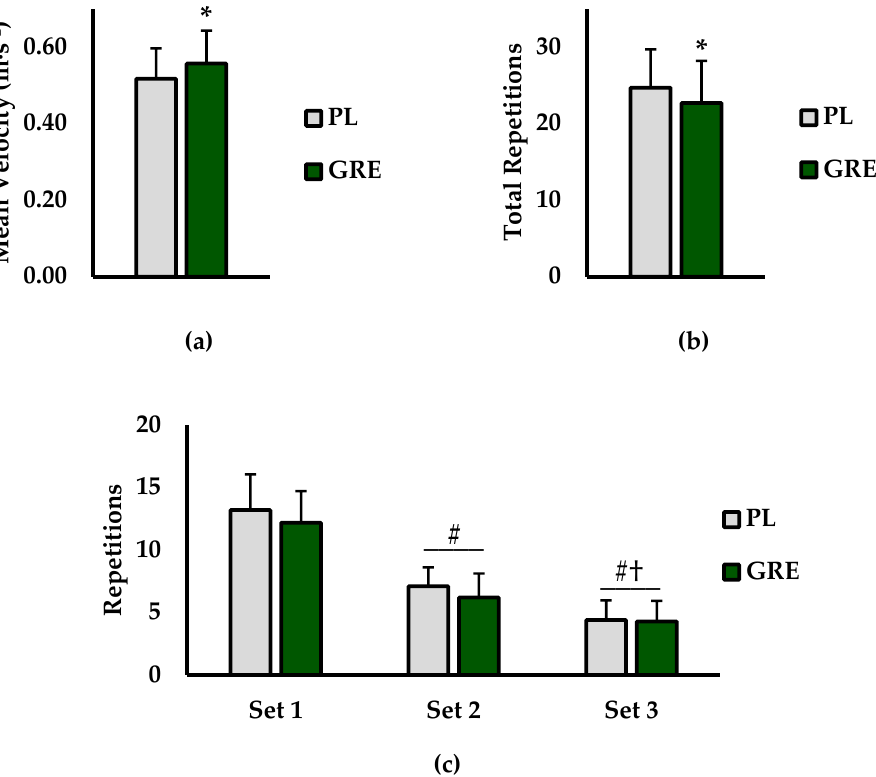
Figure 2. ( a ) Mean velocity (m ∙ s − 1 ), ( b ) Total repetitions to failure (total repetitions), and ( c ) Set ‐ to ‐ set repetitions to failure (repetitions) compared between placebo (PL; grey bars) and golden root extract (GRE; green bars). * indicates significantly different from GRE ( p < 0.05). # indicates significantly different from set 1 ( p < 0.05). † indicates significantly different from set 2 ( p < 0.05).